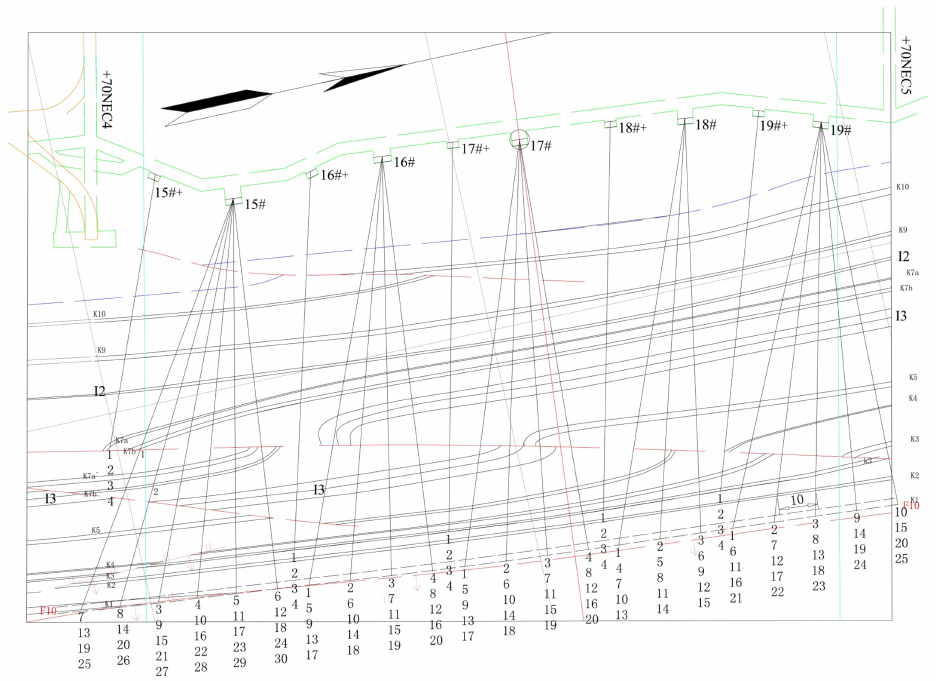
Figure 18. Borehole layout at the Zhongliangshan South